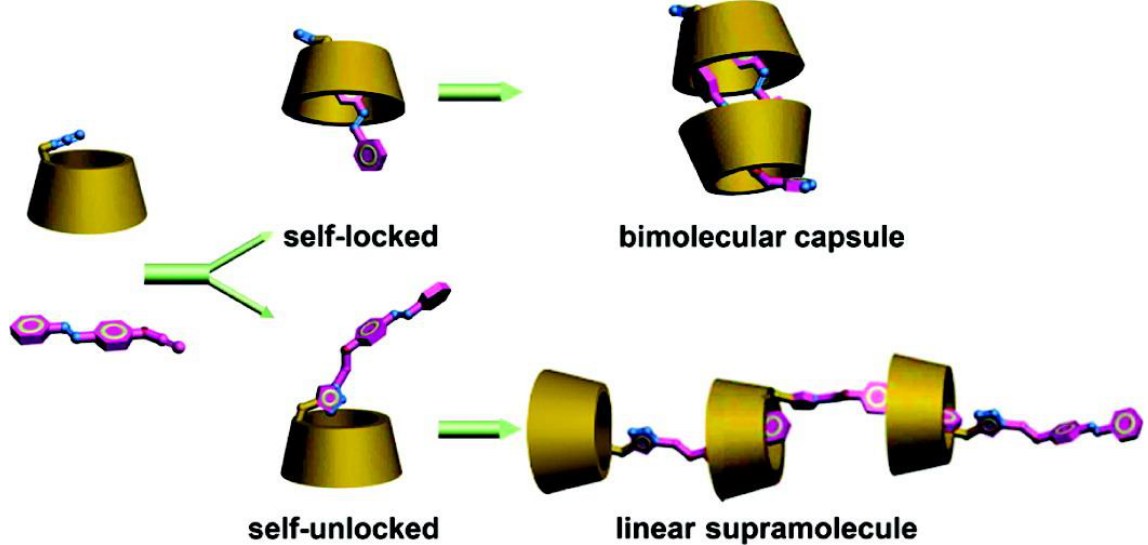
Figure 20. Self locking/unlocking molecules upon their way of synthesis. Reuse (reprint) with permission of Liu, Y.; Yang, Z.-X.; Chen, Y. Syntheses and Self-Assembly Behaviors of the Azobenzenyl Modified β -Cyclodextrins Isomers. J. Org. Chem. 2008, 73, 5298 – 5304, doi:10.1021/jo800488f.Copyright (2008) American Chemical Society.